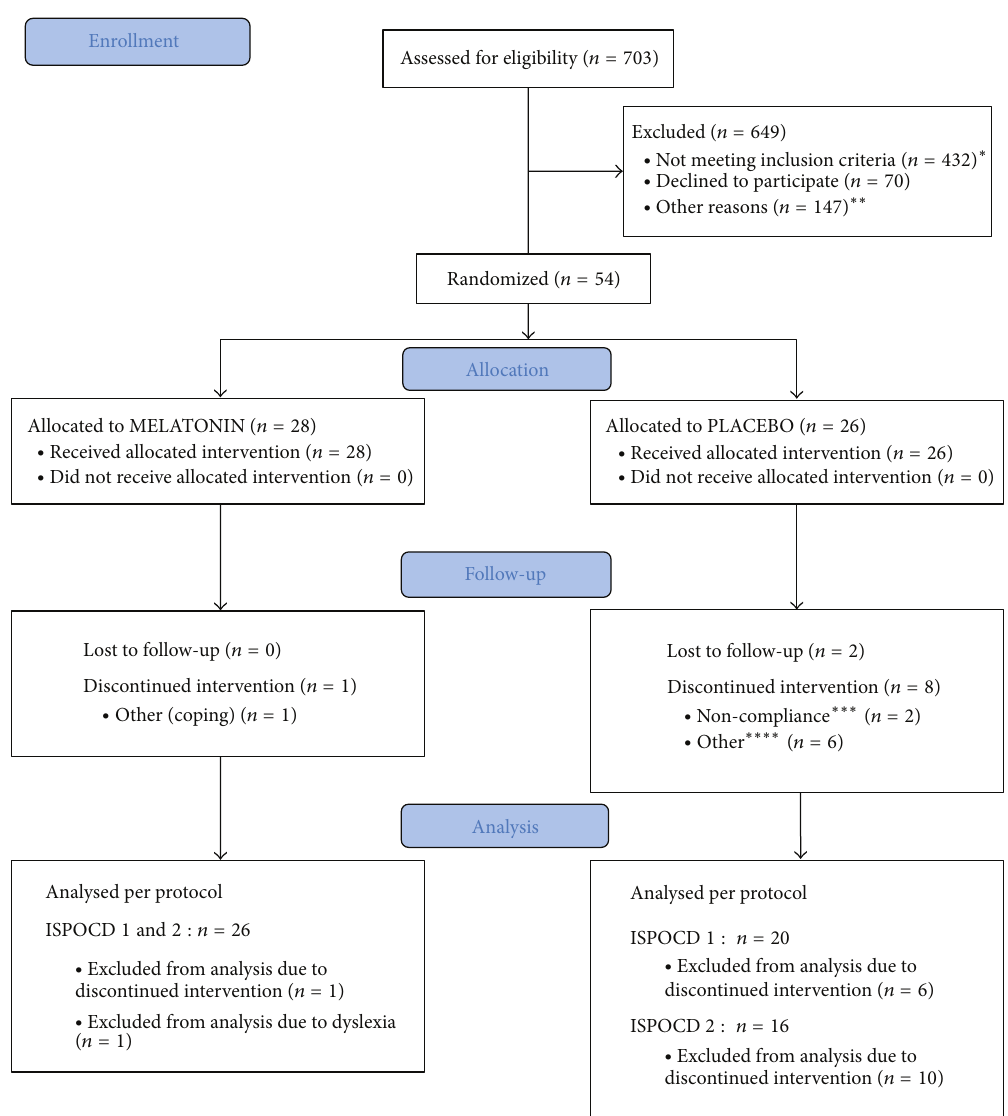
Figure 1: CONSORT 2010 flow diagram. ( ∗ ) age > 70/75 years = 134, DCIS or Mb. Paget = 30, preoperative chemotherapy = 51, selective serotonin reuptake inhibitors, antithrombotic drug therapy, monoaminoxidase inhibitors, calcium channel blockers = 31, epilepsy = 1, known and treated sleep apnea = 1, diabetes mellitus treated with insulin = 4, ongoing or previous medically treated depression or bipolar disorder = 44, known autoimmune disease = 9, severe kidney disease = 1, previous or other current cancer = 75, known medically treated sleep disorder = 1, daily intake of > 5 units (1 unit = 8g pure alcohol) = 3, preoperative, continuous treatment with psychopharmacological drugs of any kind, opioids, anxiolytics, or hypnotics = 35, and predicted poor compliance = 12. ( ∗∗ ) Logistics = 50, < 3 days till the day of surgery = 82 and patient recruited for other trial = 15. ( ∗ ∗ ∗ ) Taken < 75% of the trial medication at visit 2. ( ∗ ∗ ∗∗ ) Adverse events = 2 (one patient had insomnia at night and sleepiness during the day and the other had headaches) and coping =